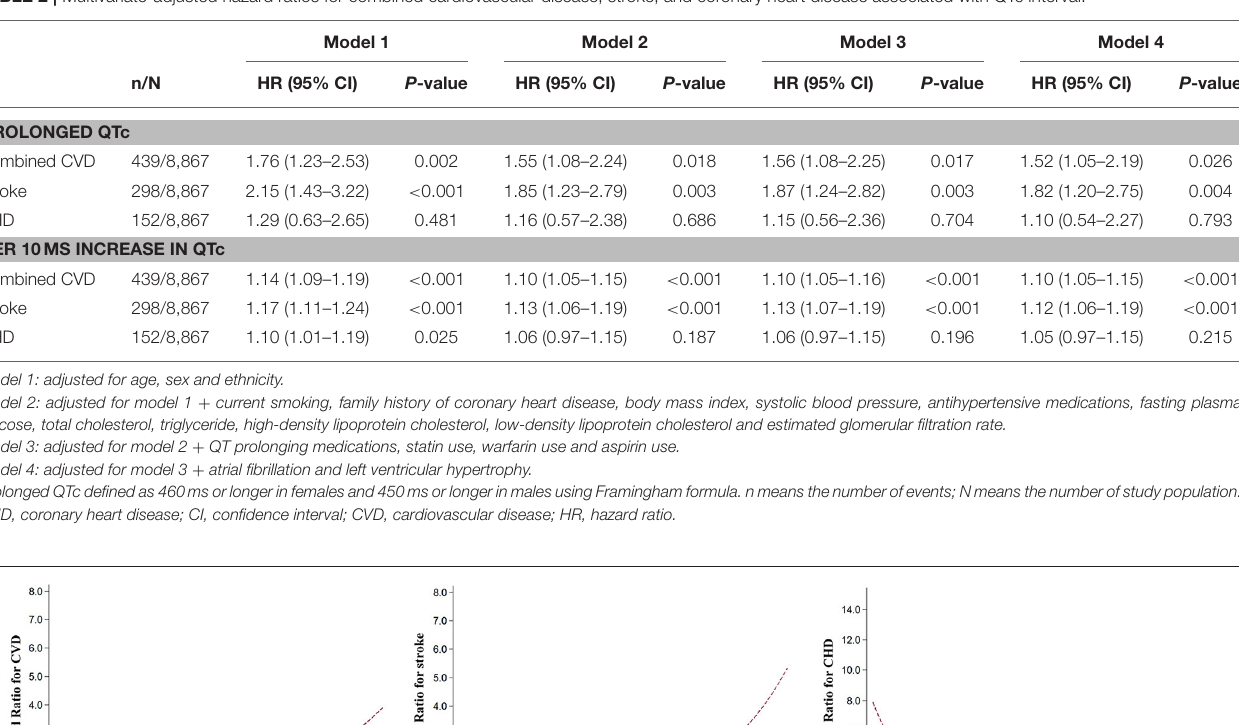
TABLE 2 | Multivariate-adjusted hazard ratios for combined cardiovascular disease, stroke, and coronary heart disease associated with QTc interval.